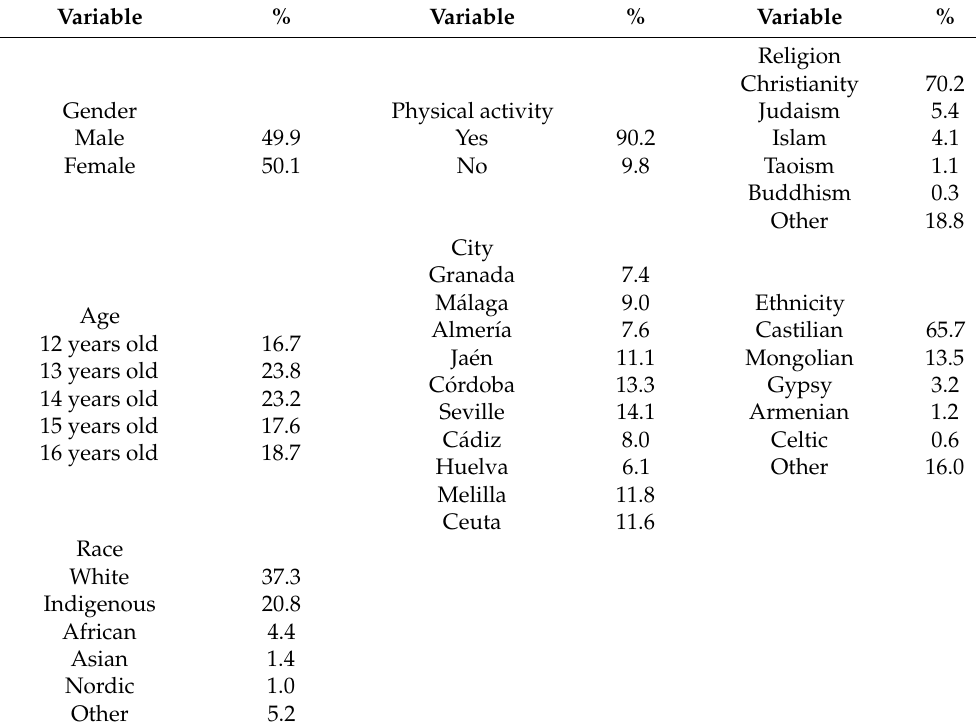
Table 3. Sociodemographic profile.